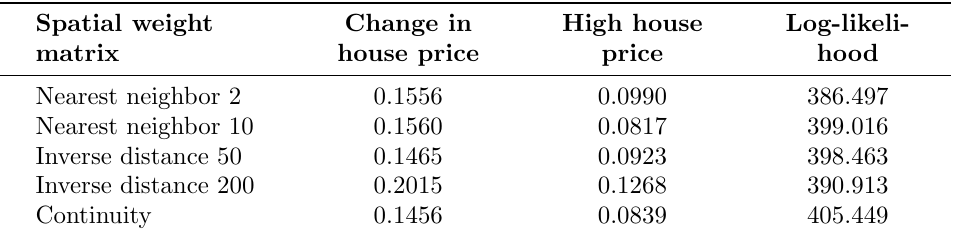
Table 6: Spatial Durbin Model with different spatial weight matrices Spatial